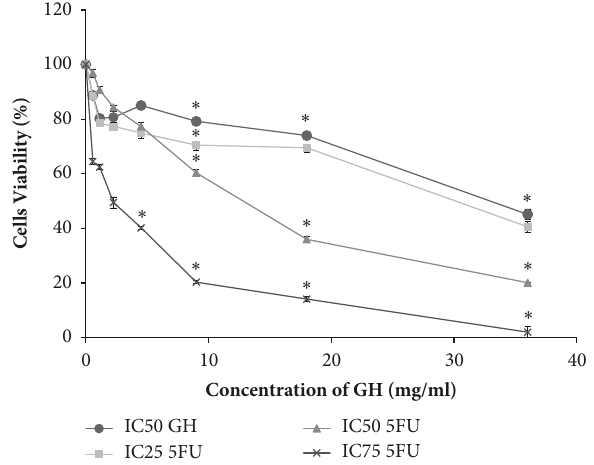
Figure 2: Effects of GH at CD 50 concentration on the viability of HT-29 cells after incubation in different concentrations of 5-FU for 72 h. Each point represents the mean of the results of three independent experiments. Error bars represent means ±